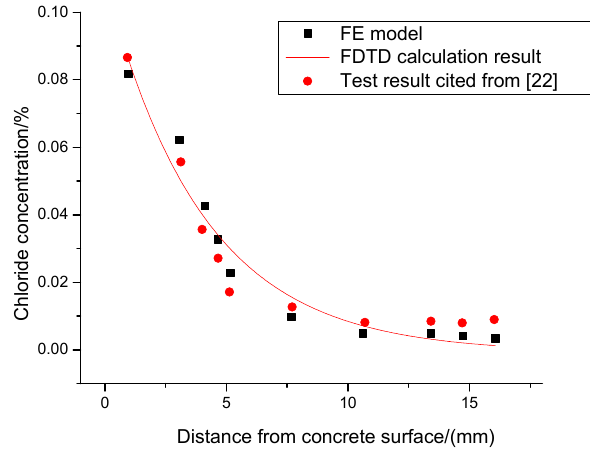
Figure 7. Comparing results.